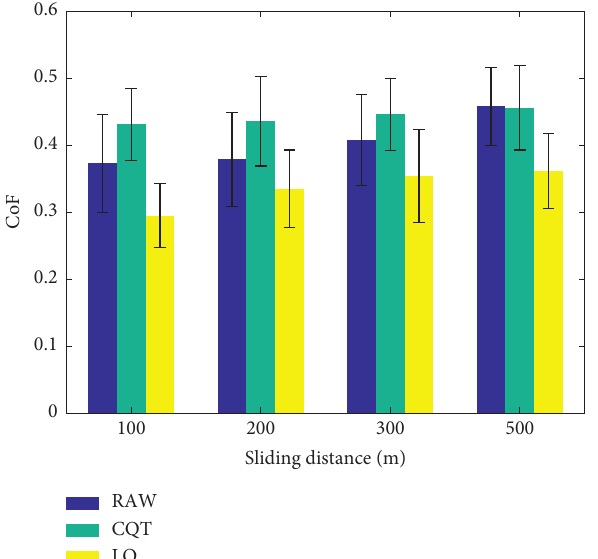
Figure 6: Friction coefficient of samples under different conditions and sliding distances.